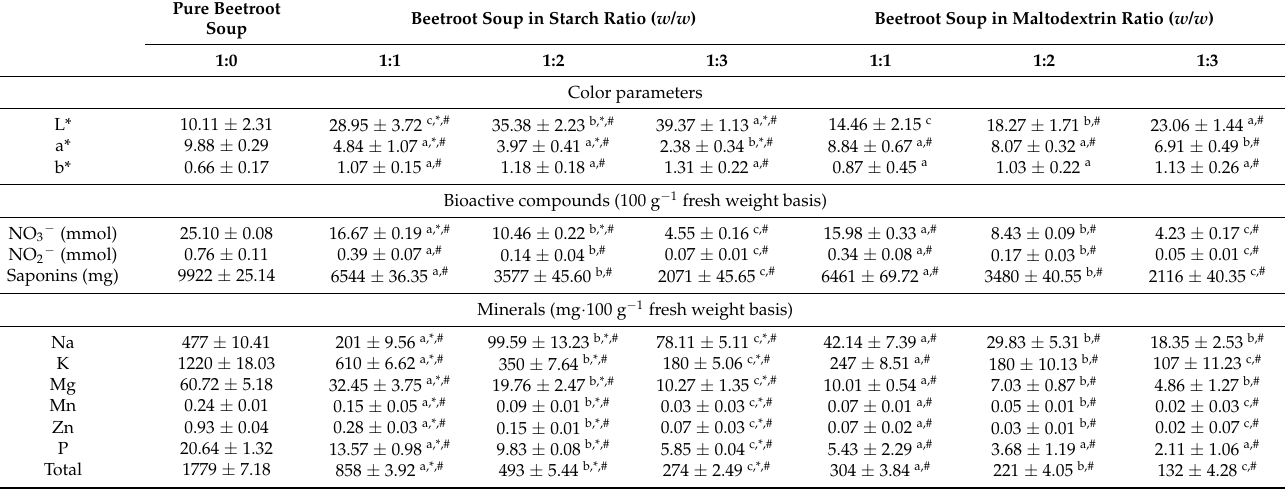
Table 3. Color parameters, NO 3 − , NO 2 − and average essential mineral contents of lyophilized beetroot soup